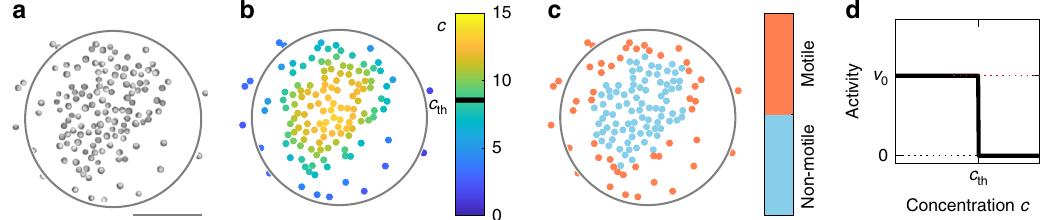
Fig. 1 Collective behaviour of active particles with quorum-sensing rules. a Experimental snapshot of a two-dimensional suspension of carbon-coated APs with size σ = 4.4 μ m (scale bar 50 μ m). Upon laser illumination, particles self-propel as a result of a local demixing process in the binary solvent. b The colour code corresponds to the chemical concentration c which is attributed to each particle according to Eq. (1) for a decay length λ = 10 σ . c Corresponding particle activity obtained by the concentration-dependent motility rule shown in d with concentration threshold c d Concentration-dependent particle motility with self-propulsion velocity v 0 below the threshold c